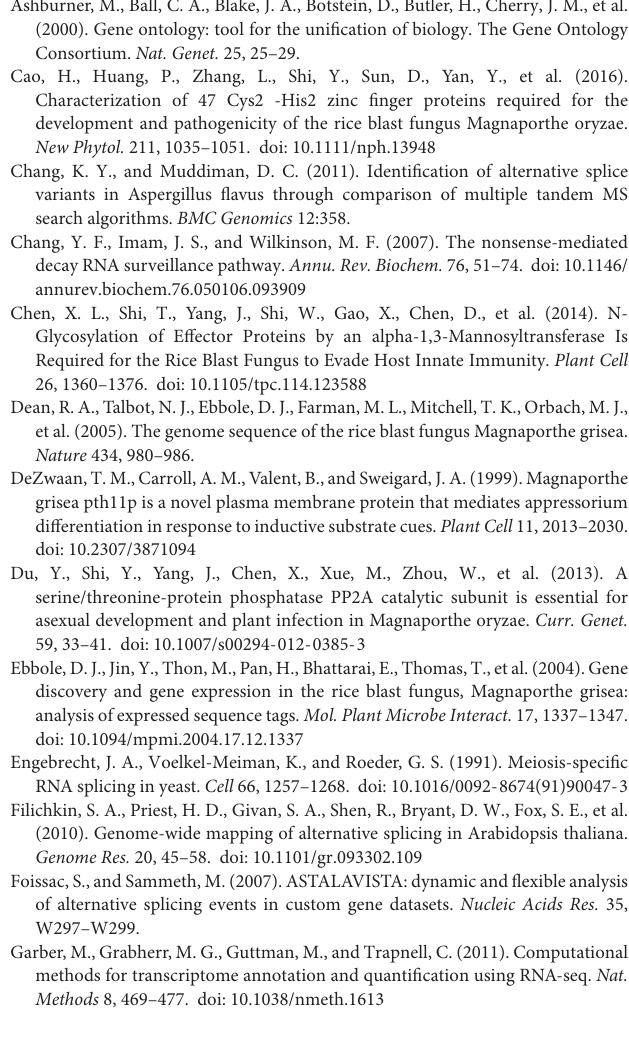
Supplementary Figure 9 | Regulations of chitin synthesis and degradation. (A) Pathways of chitin synthesis and degradation. Genes represented by red boxes are up-regulated in conidia compared with hyphae. (B–F) Comparison of gene expression levels of CHS , chitinases, beta- N -acetyl hexosaminidases, chitin